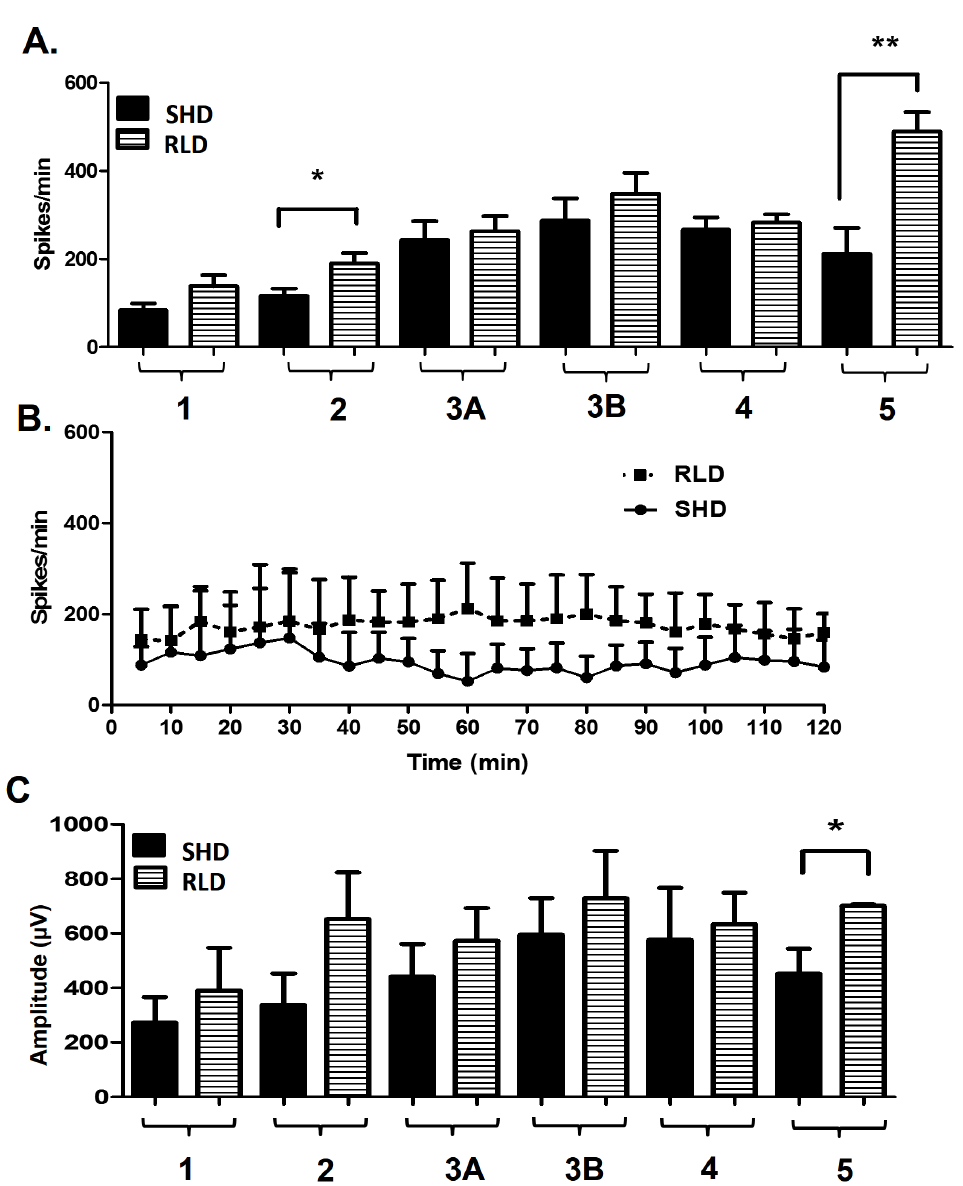
Figure 6. The RLD group had a higher spike count (per min) than the SHD group. Spike counts were higher across all stages of seizures (A) or in the total spike count during the entire 2 h duration of SE following RLD (B). The increase in spike counts was significantly greater during stage-2 (p=0.021) and stage-5 (p=0.0012) seizures in the RLD group than in the SHD group (A). The mean values of spike rate shown at 5 min epochs revealed a significant increase in the RLD group than in the SHD group (two way ANOVA, p=0.0001, n=9 each). C : The spike amplitude during the 2 h SE was greater in stage-3B $ stage-2 . stage-3A $ stage-4 $ stage-5 . stage-1. There was a significant increase in spike amplitude for stage-5 seizures in the RLD group (p=0.024, n=9 each, unpaired